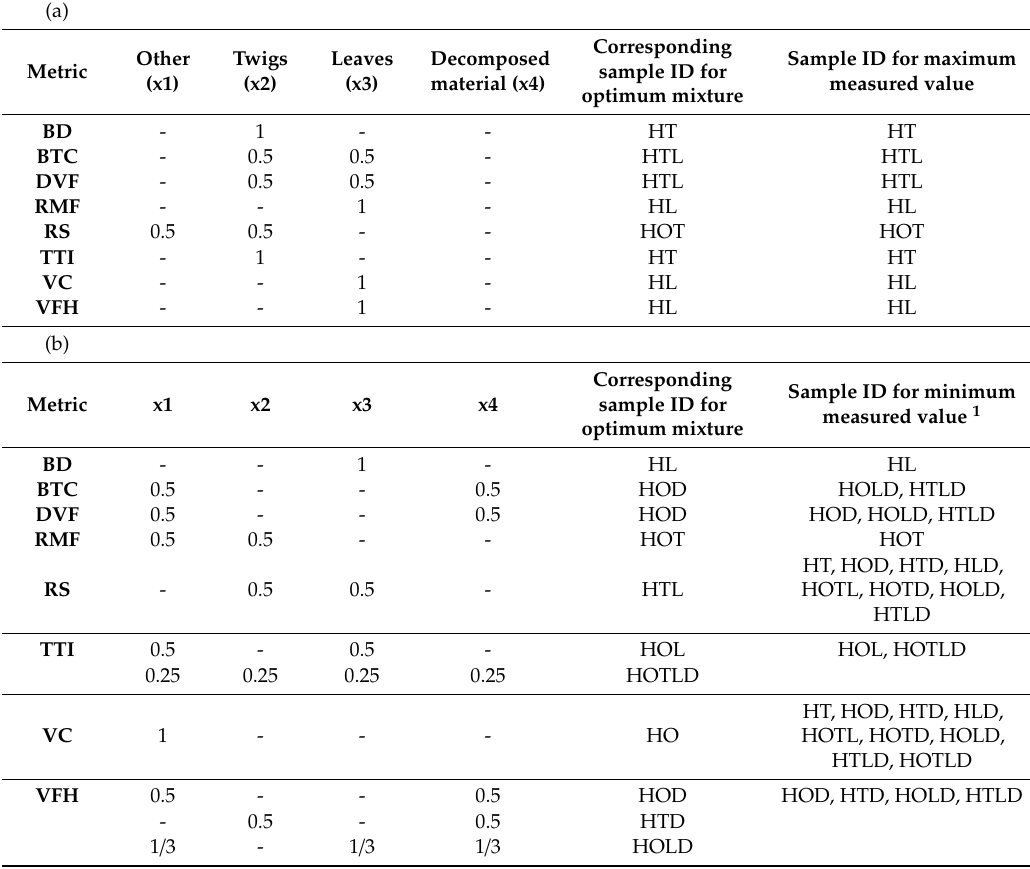
Table 8. Optimisation of the ideal mixture for (a) maximum and (b) minimum flammability for litter from Halls Creek for bulk density (BD), burn to completion (BTC), duration of visual flaming (DVF), residual mass fraction (RMF), rate of spread (RS), time-to-ignition (TTI), volume consumed (VC), and vertical flame height (VFH). Values represent the proportion of each litter component within a mixture. Key to flammability mixtures for litter from Halls Creek (H): other (O), twigs (T), leaves (L), decomposed material (D). 1 Only if the mixture